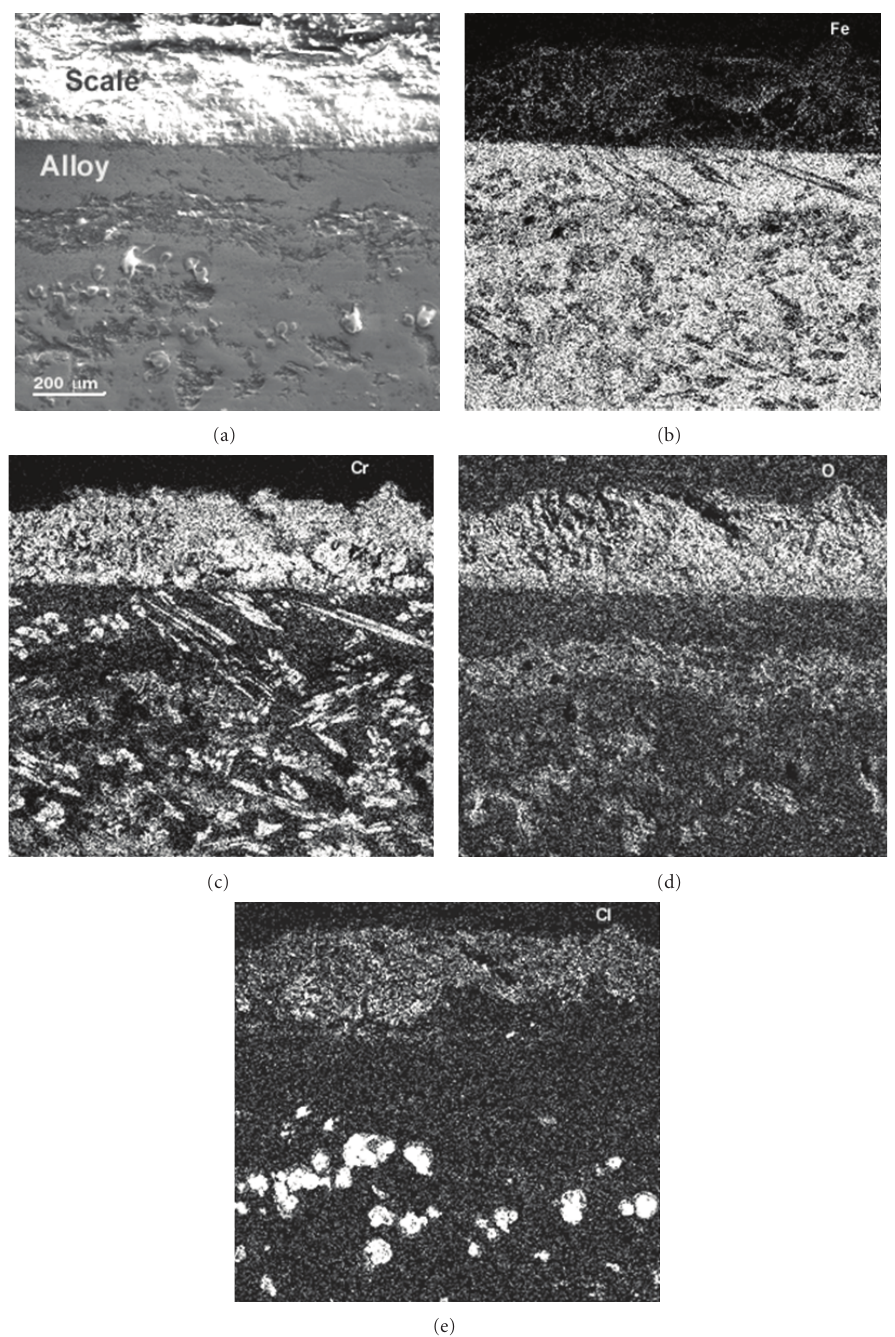
Figure 6: Micrograph of cast iron containing 3.97 C E -corroded NaCl-KCl at 670 ◦ C during 96 h together with X-ray mappings of Fe, Cr, O, and